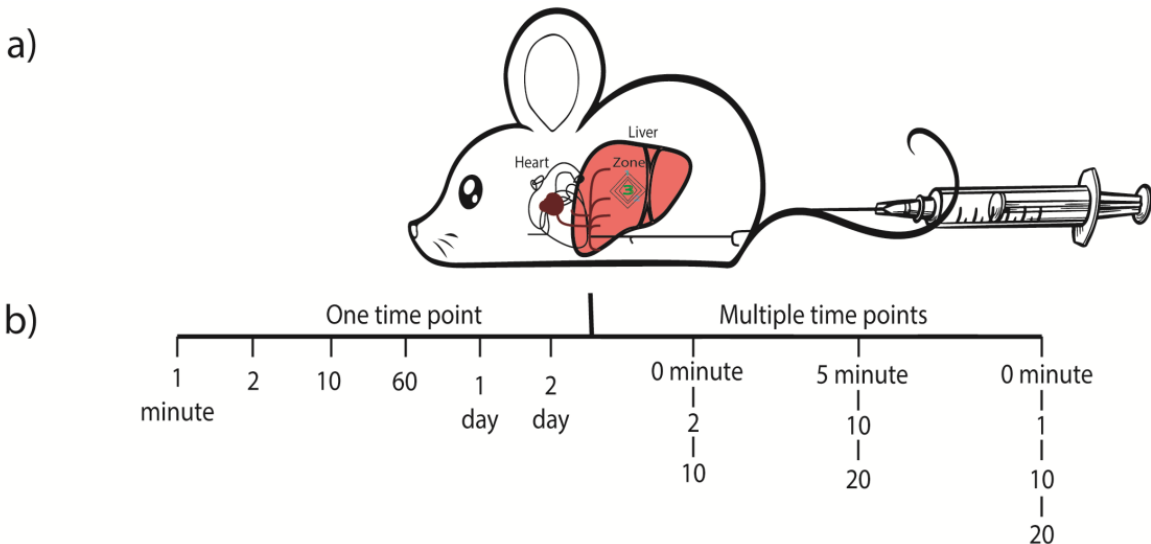
Figure 1. Schematic diagram showing ( a ) Hydrodynamic injection into the tail vein of C57BL/6J/129Sv mice. Briefly, 2 mL volume of empty vector or saline solution (control) was hy-drodynamically injected into the tail vein of anaesthesized C57BL/6J/129Sv mice. ( b ) Liver tissue was resected at different time points and quickly fixed with buffered 1% osmium tetroxide. For electron microscopic evaluation, ultrathin sections were cut from glycidether embedded blocks.